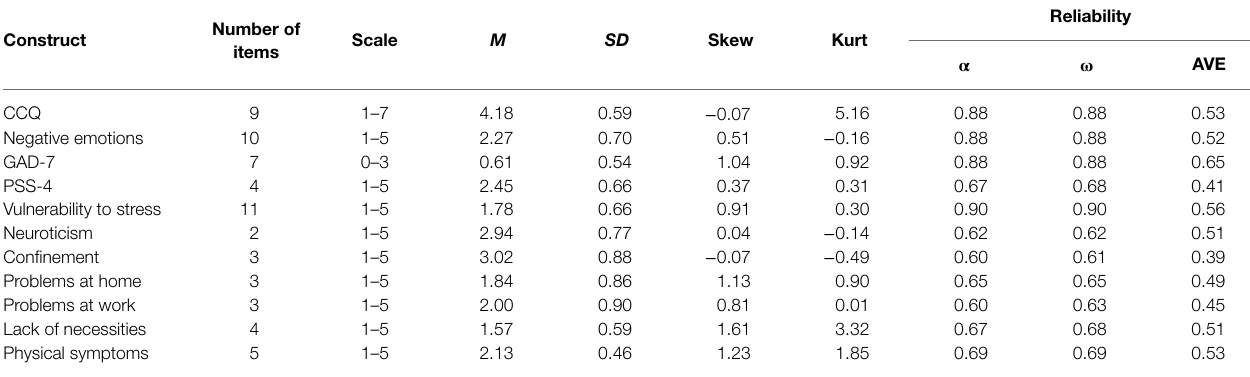
TABLE 3 | Descriptive statistics and the reliability of the scale scores ( N = 830).